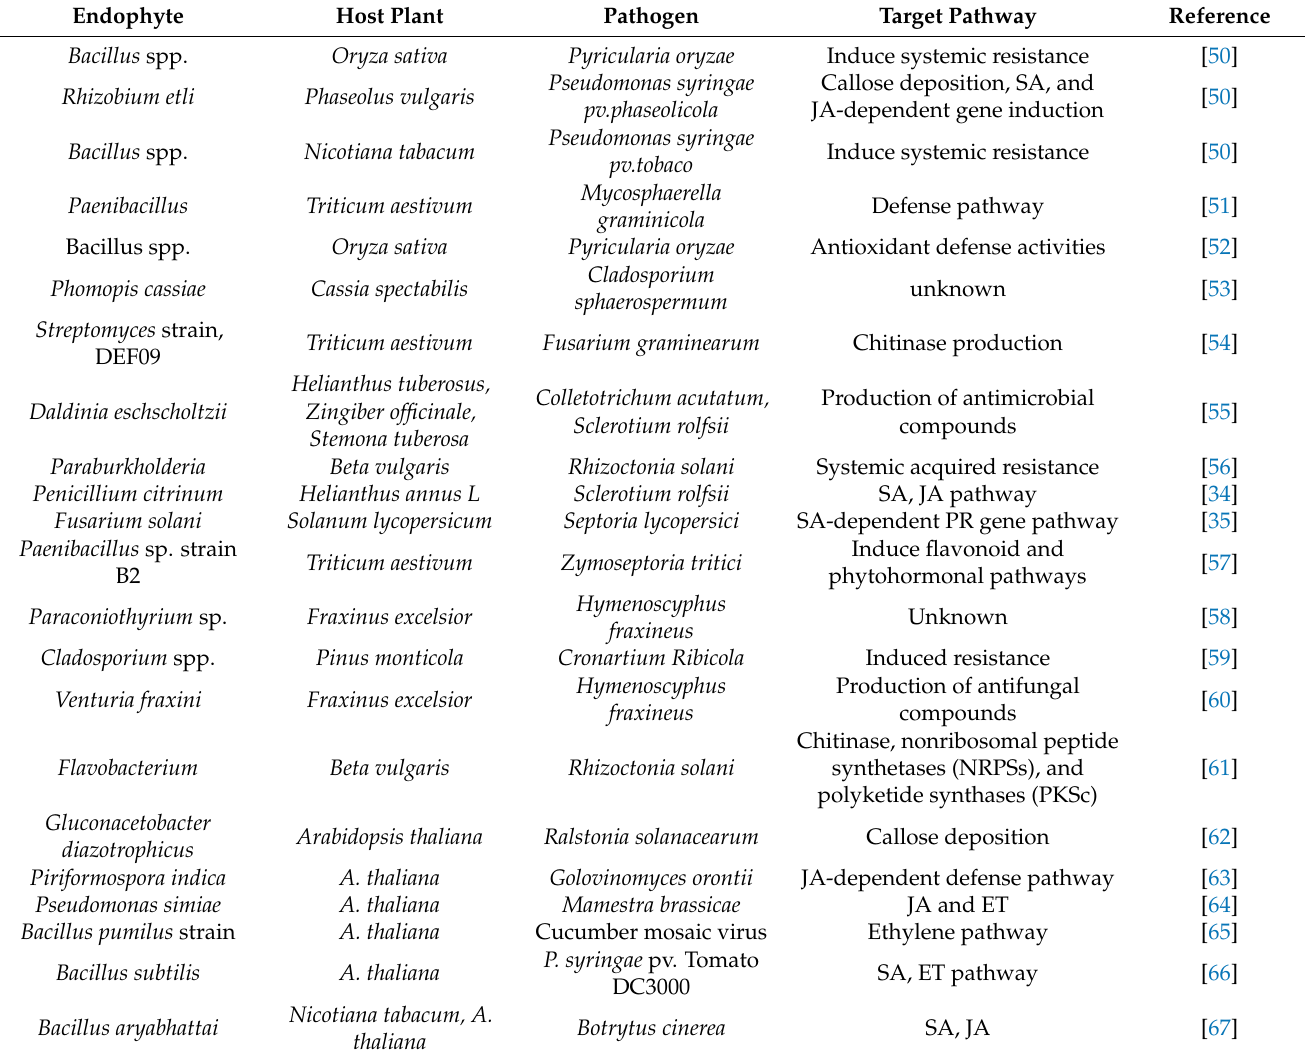
Table 1. List of endophytes associated with defense against various plant